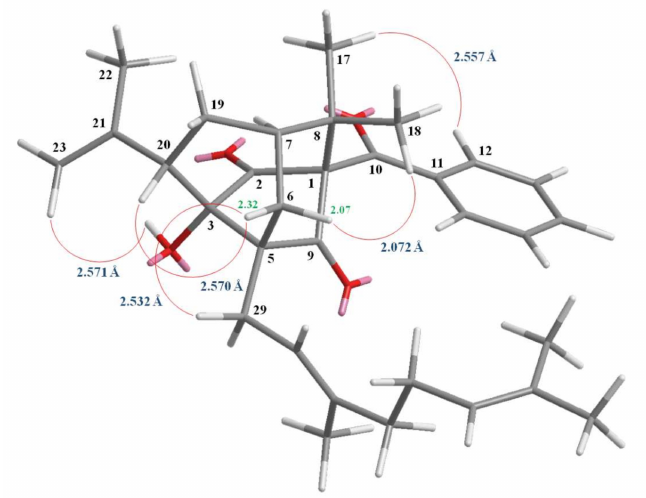
Figure 4. Selected rotating frame nuclear Overhauser e ff ect spectrometry (ROESY) correlations and relative configuration of 2 .